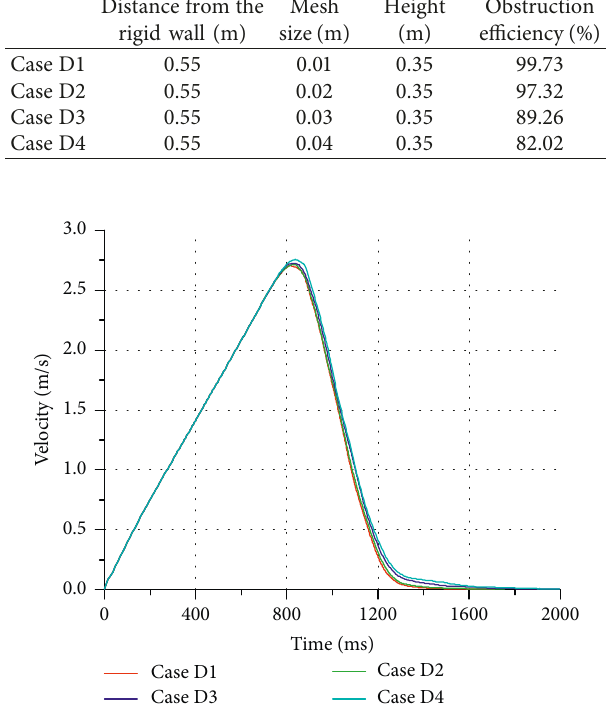
Figure 17: Time history of the graded granular flow velocity when RNB with different mesh sizes was placed.